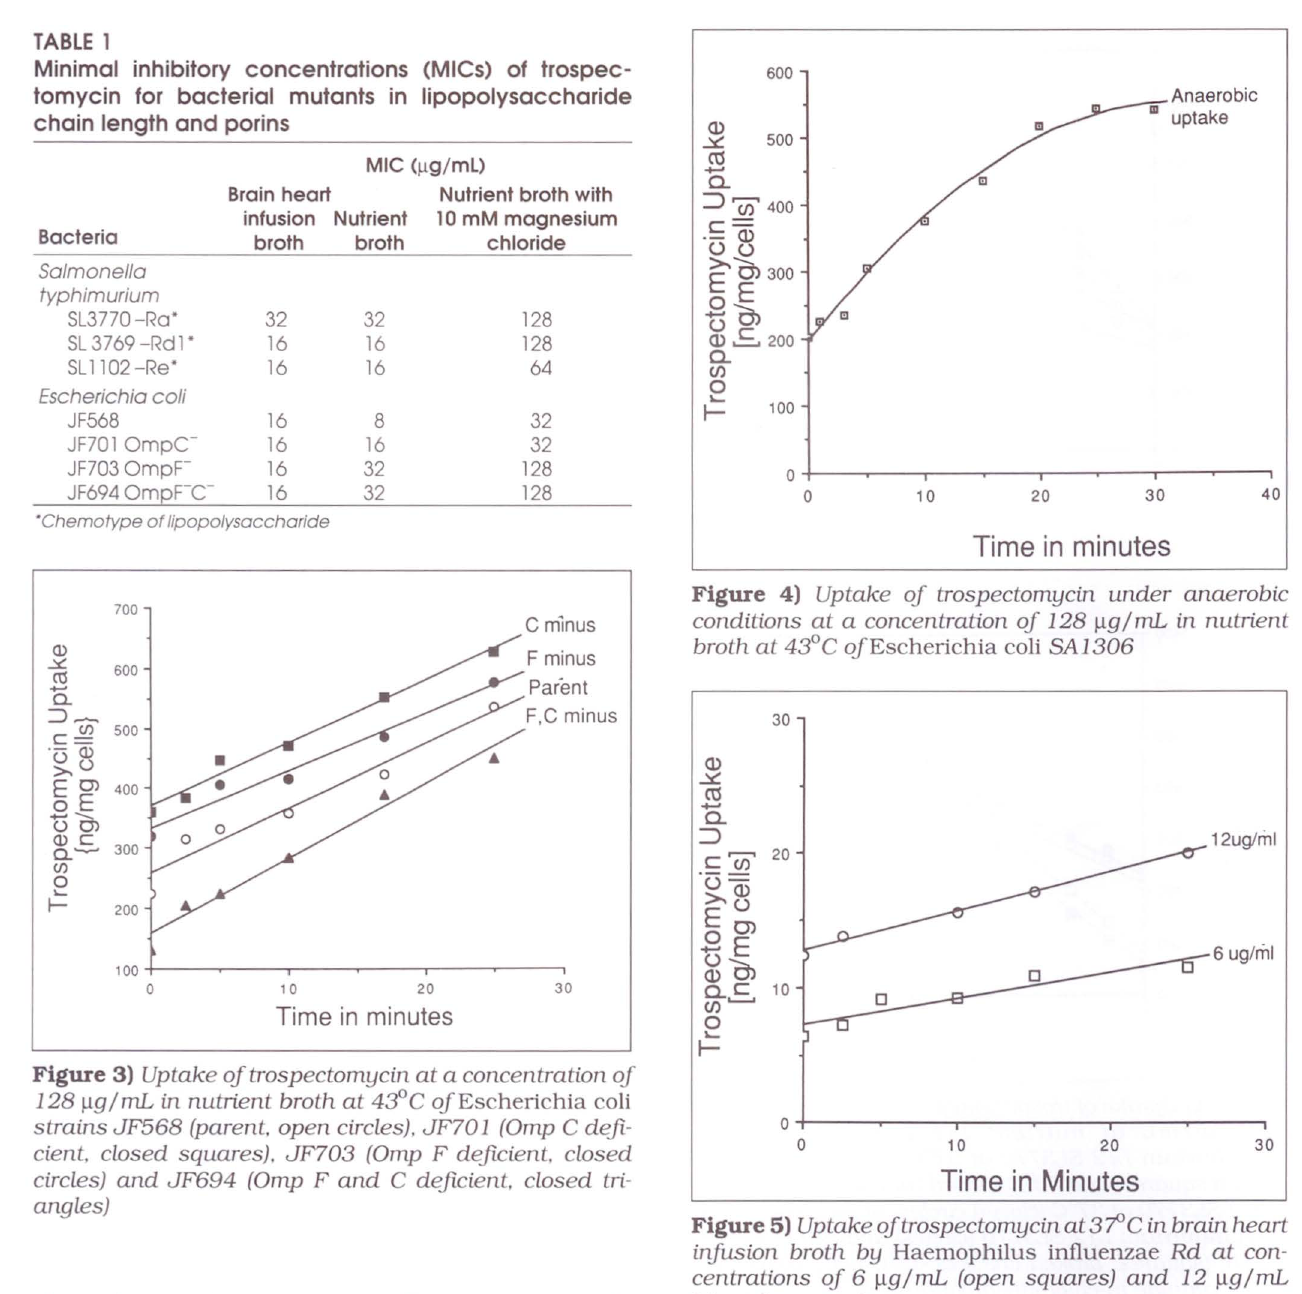
ever, no appreciable consistent difference in up take among the four strains could be detected (Figure 3). The inclusion of 10 mM magnesium chloride in nutrient broth increased MICs of both E coli and S typhimurium strains fourfold. S typhimurium LT2 strain SL1102 showed some what greater uptake in nutrient broth than in the same medium with 10 mM magnesium chloride, but no difference was detected with strain SL3770 (Figure 2). The authors also examined uptake in E coli AB2495 and its rpsE- ribosomally spec tinomycin-resistant derivative K.L252 and in E coli CAN J INFECT DIS VOL l No 2 SUMMER